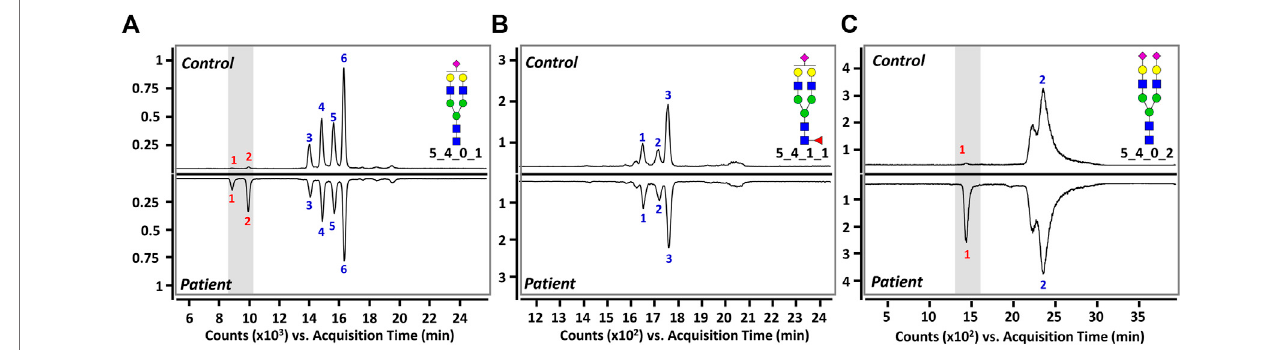
FIGURE3| RepresentativePGC-LC/MRMchromatograms of (A) Hex 5 HexNAc 4 NeuAc 1 , (B) Hex 5 HexNAc 4 Fuc 1 NeuAc 1 ,and (C) Hex 5 HexNAc 4 NeuAc 2 inhuman serum.Topand bottompanelsdisplayhealthycontrolsandBDpatients,respectively.Agray barindicates isomerswithmarkedlydifferentbetweenhealthycontrolsand patients. For the glycan cartoons, green circles denote mannose, yellow circles denote galactose, blue squares denote N -acetylglucosamine, red triangles denote fucose, and purple diamonds denote N -acetylneuraminic acid.